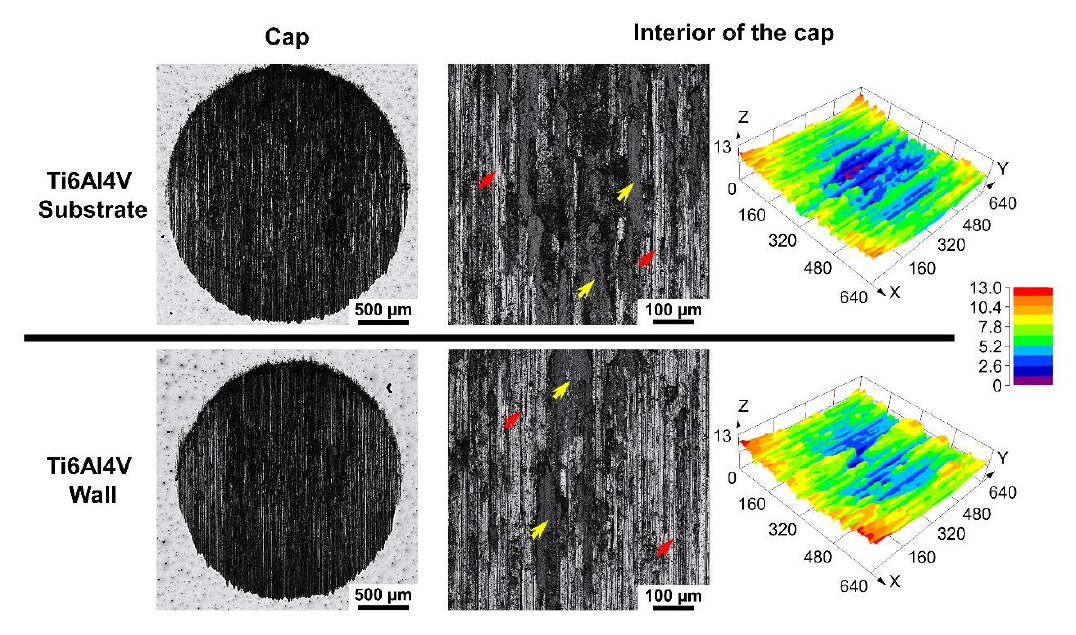
Figure 8: Optical micrograph of the wear caps and interior of the wear caps from the substrate and WALL (f). Travelled distance: 880 m (40 min). The yellow and red arrows indicate the mechanisms of adhesive and abrasive wear on two bodies,